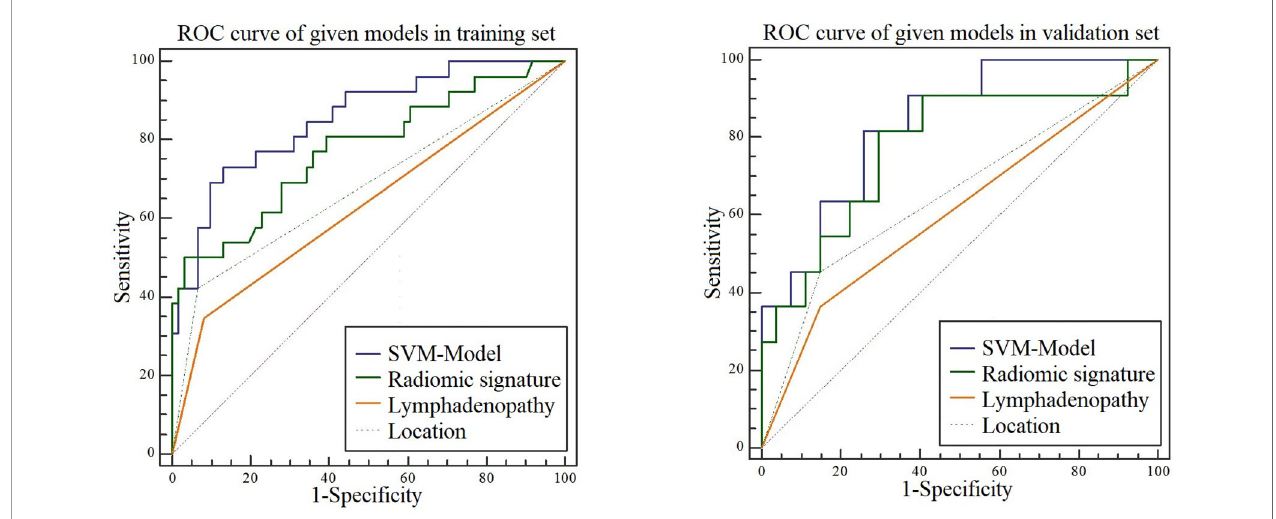
FIGURE 5 | ROC curves for the SVM model, radiomic signature, location, and lymphadenopathy when predicting malignancy in the training and test